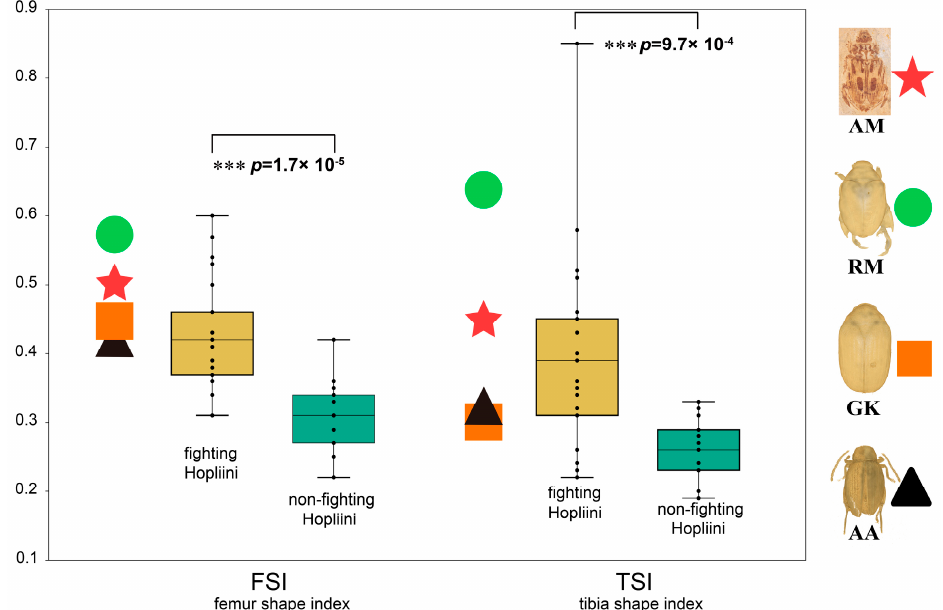
Figure 4. Fighting function of the hind legs based on the morphometric analyses of FSI and TSI compared between fighting and non-fighting Hopliini. Abbreviations: AA: Aphthonoides armipes (Alticinae); AM: Antiqusolidus maculatus sp. n. (fossil); FSI: femur shape index; GK: Gastroserica kucerai (Melolonthinae); TSI: tibia shape index; RM: Repsimus manicatus (Rutelinae). ∗∗∗ p < 0.001.